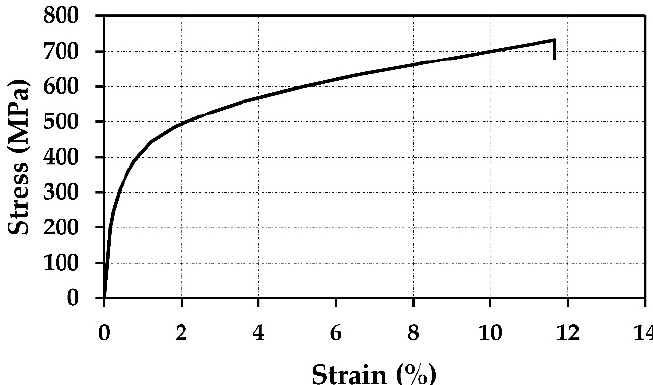
Figure 1. Stress-strain curve of FeMnSi SMA [27].